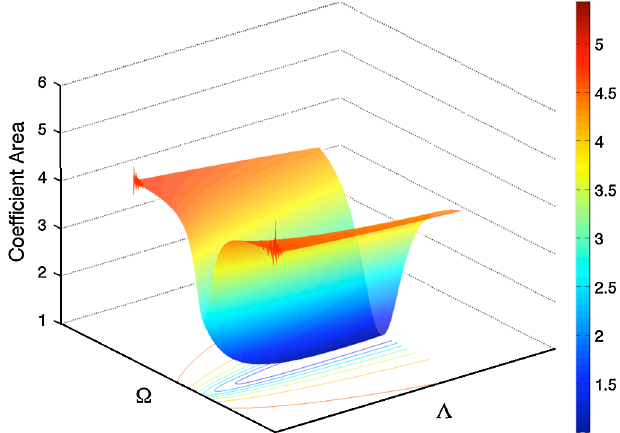
FIG. 2. (Color) Topology of the coefficient area map for a purely (0,0) mode with (cid:2) ¼ 4 : 0252 and (cid:1) ¼ 1 : 25 over the ranges (cid:1) 3 (cid:3) (cid:7) (cid:1) (cid:7) 3 (cid:3) and 0 : 1 (cid:3) (cid:3)R 2 (cid:7) (cid:2) (cid:7) (cid:3)R 2 .